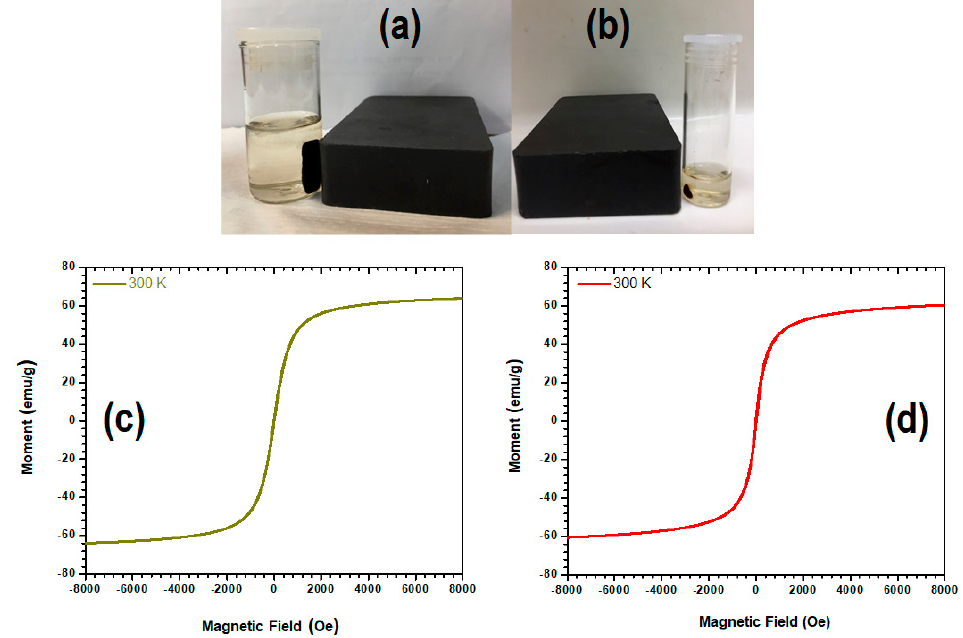
Figure 6. A depiction of ( a ) pristine SPIONs and ( b ) CLA-coated PTX-SPIONs localized by a magnet, and magnetization hysteresis loops of ( c ) pristine SPIONs and ( d ) CLA-coated PTX-SPIONs at 300 K and magnetic field range of − 8000 to 8000 Oe. Table 1. Saturation magnetization and coercivity of pristine SPIONs and the CLA-coated PTX-SPI- ONs as determined by VSM analysis.